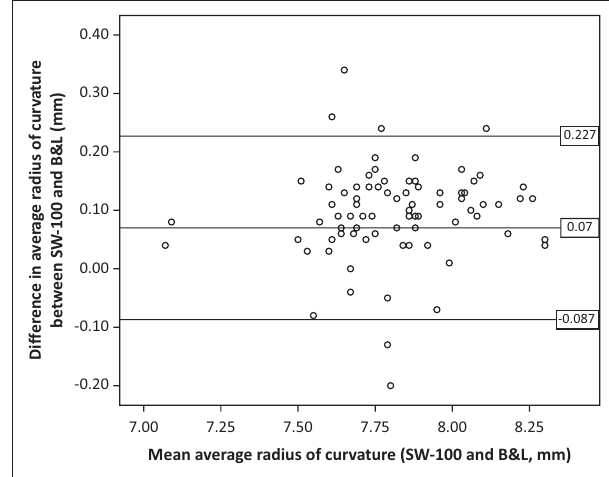
FIGURE 3: Differences in average radius of curvature between SW-100 autokeratometer and Bausch & Lomb keratometer, plotted against the mean average curvatures of horizontal and vertical